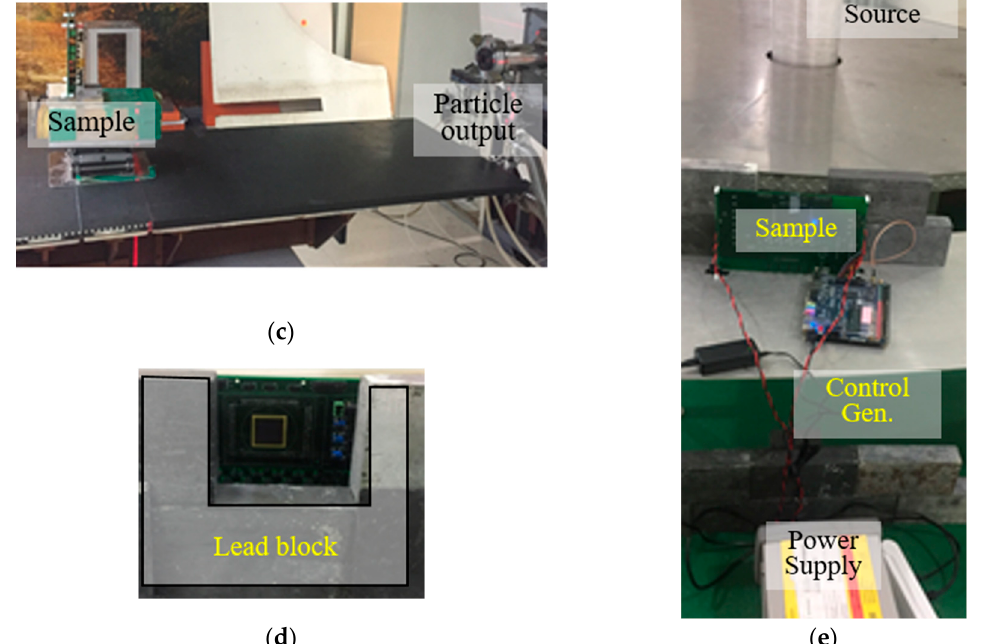
Figure 10. Radiation test setup: ( a ) Simplified block diagram; ( b ) Displacement damage dose (DDD) test with metal shielding to protect the other electrical parts; ( c ) DDD test setup without metal shielding; ( d ) Front view of total ionizing dose (TID) test setup using lead blocks; ( e ) Overall TID test setup including radiation source.